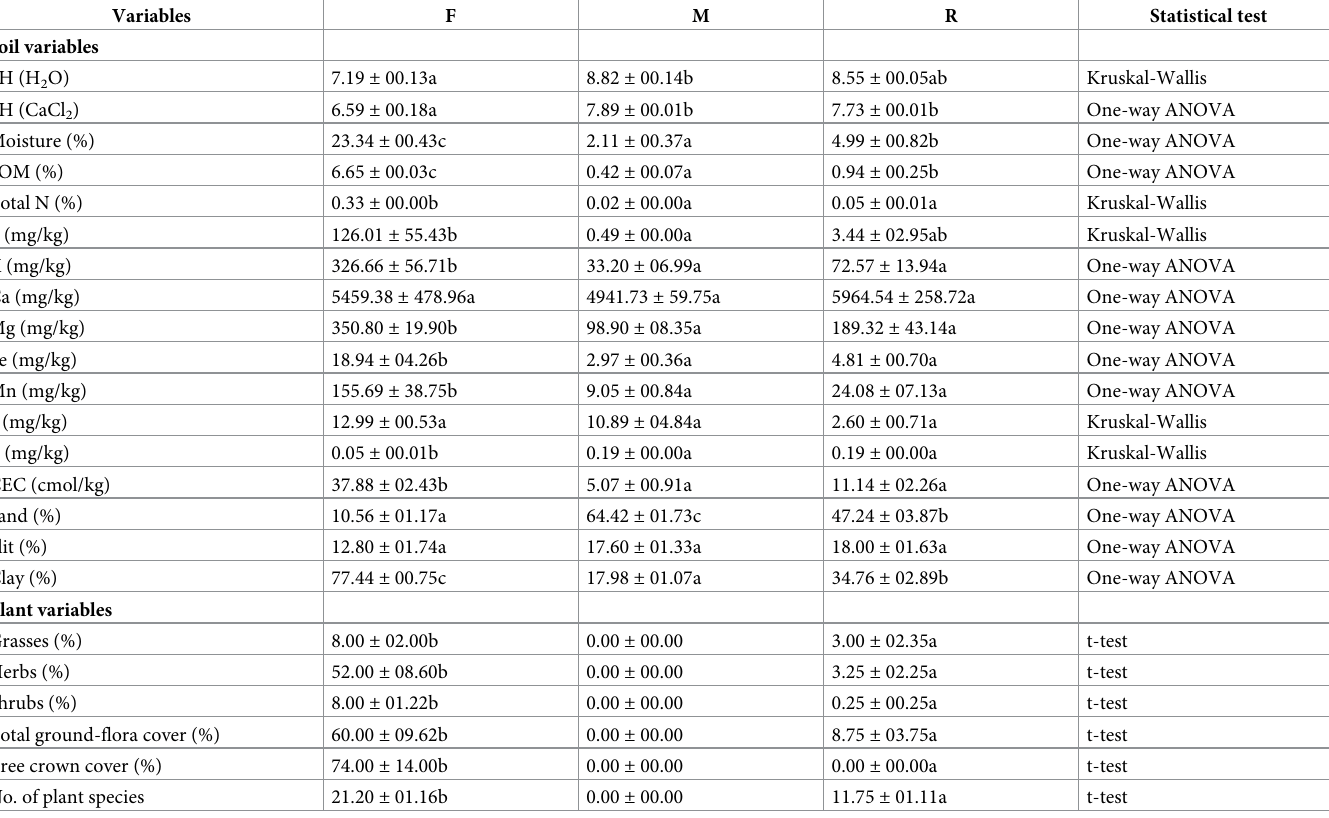
Table 1. Physico-chemical properties of soil/substrate and plant variables. Variables Statistical